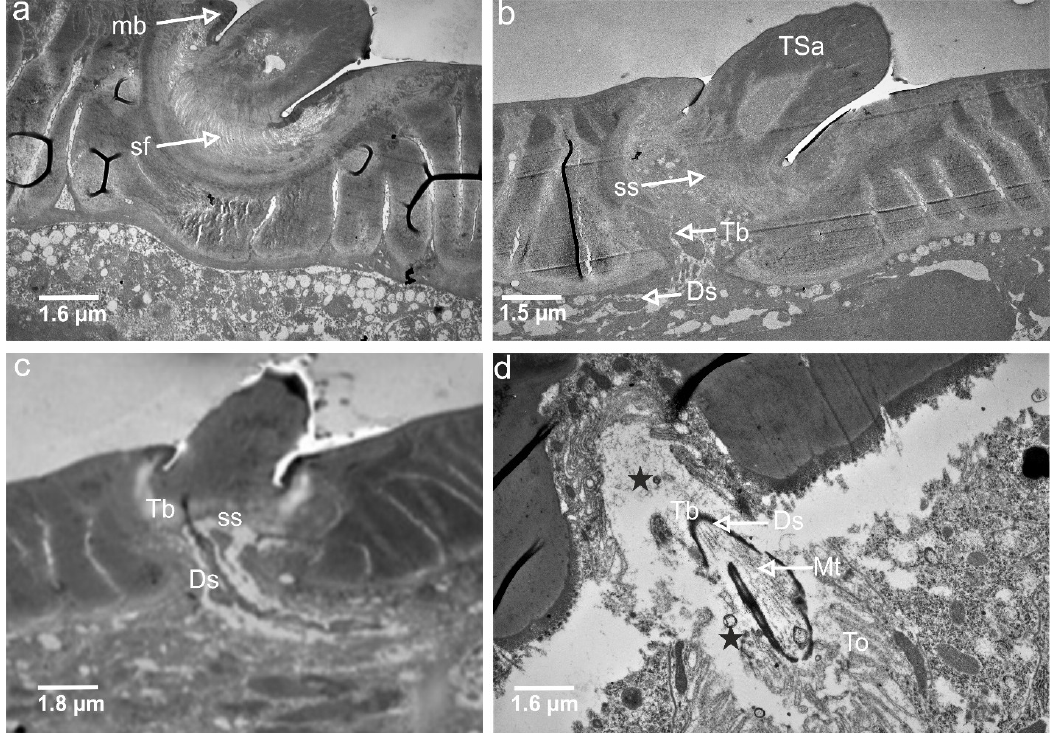
Figure 5. TEM photograph explores the ultrastructure of a longitudinal/oblique section of the flexible socket and section of the tubular body of trichoideum sensillum of N. rugosus antennae: ( a ) section by flexible socket, where the shape of the membrane and suspension fibre is visible; ( b , c ) deeper section of the mechanoreceptor, where the dendrite coupling to the base of the socket is clearly visible; ( d ) tubular body in the oblique section. ss, socket septum; Ds, dendrite sheath; sf, suspension fibre; Mt, microtubules; To, tormogen cell; black stars, lymph cavity; mb, socket membrane or joint membrane; Tb, Tubular body; TSa, trichoideum sensillum.